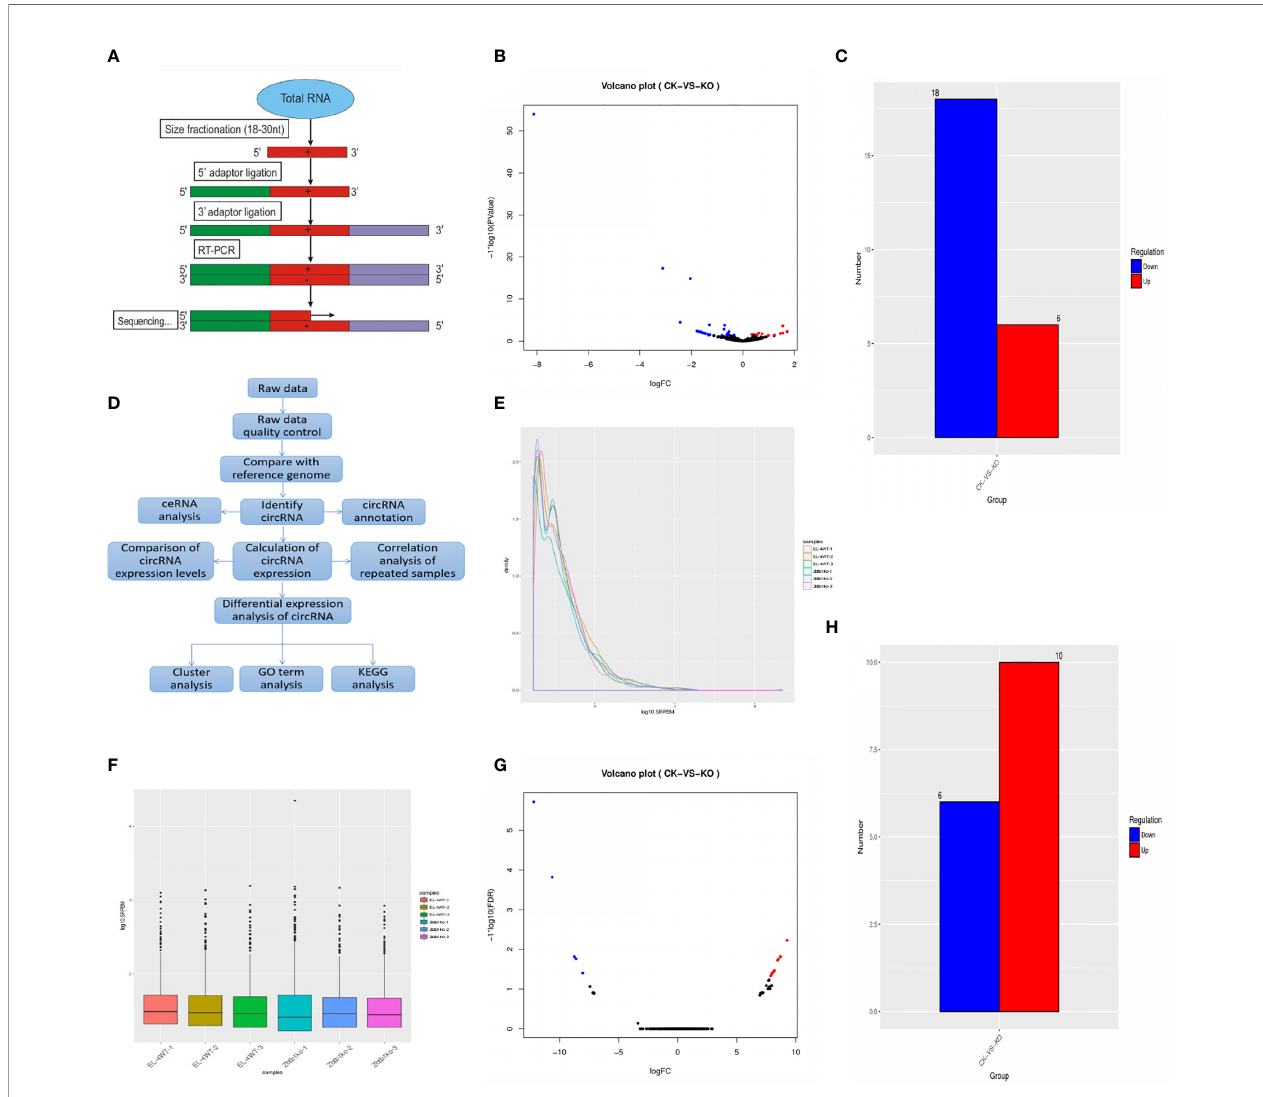
FIGURE 2 | (A) MicroRNA sequencing process; (B) Differential expression of microRNAs. Signi fi cantly different microRNAs with red dots are upregulated, and blue dots are downregulated. Abscissa represents multiple changes in microRNA expression in different samples, and ordinate represents statistically signi fi cant differences in microRNA expression; (C) Sample differences compare up- and downregulated microRNAs; (D) CircRNA analysis process; (E) SRPBM distribution map. Abscissa is log10 (SRPBM), and vertical coordinate is circRNA density; (F) SRPBM box chart. Abscissa is the name of the sample, and ordinate is the log10 (SRPBM). Box chart for each region of the fi ve statistical quantities (top to bottom is the maximum, upper quartile, median, lower quartile and minimum); (G) In the differential circRNA expression map, the red dots represent upregulated circRNAs, and the blue dots represent downregulated circRNAs. Abscissa represents multiple changes in circRNA expression in different samples, and vertical coordinates represents the statistically signi fi cant differences in circRNA expression; (H) Sample differences compare up- and downregulated